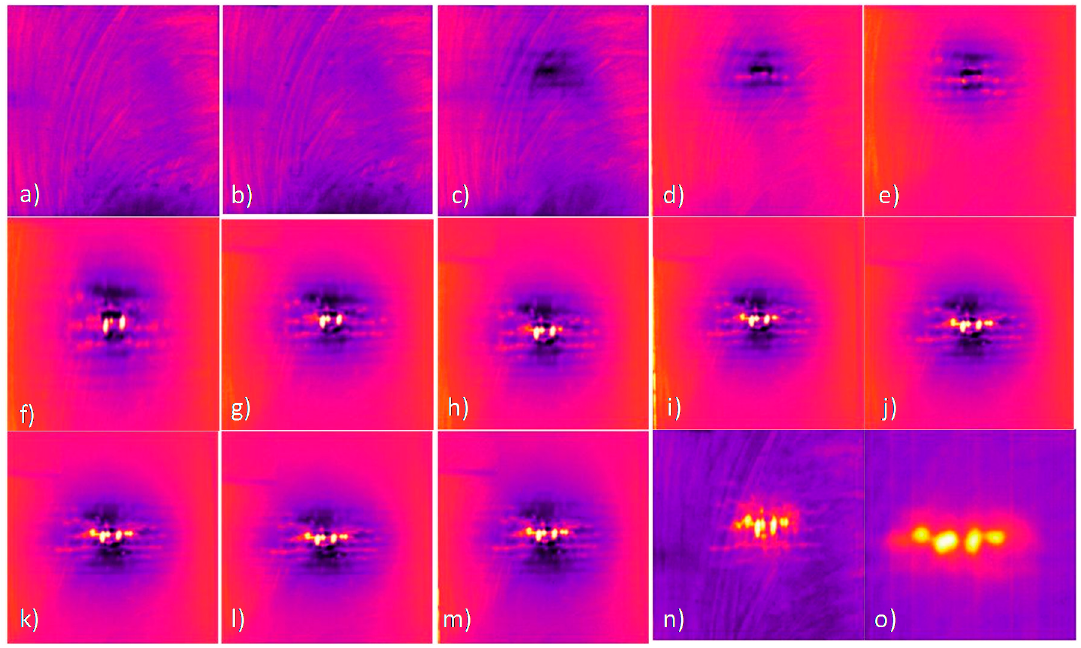
Figure 13. Some thermal images taken with SC6800 camera at different time instants during impact of a CFRP specimen. ( a ) t = 0 s; ( b ) t = 0.001 s; ( c ) t = 0.002 s; ( d ) t = 0.003 s; ( e ) t = 0.004 s; ( f ) t = 0.005 s; ( g ) t = 0.007 s; ( h ) t = 0.015 s; ( i ) t = 0.016 s; ( j ) t = 0.032 s; ( k ) t = 0.189 s; ( l ) t = 0.605 s.